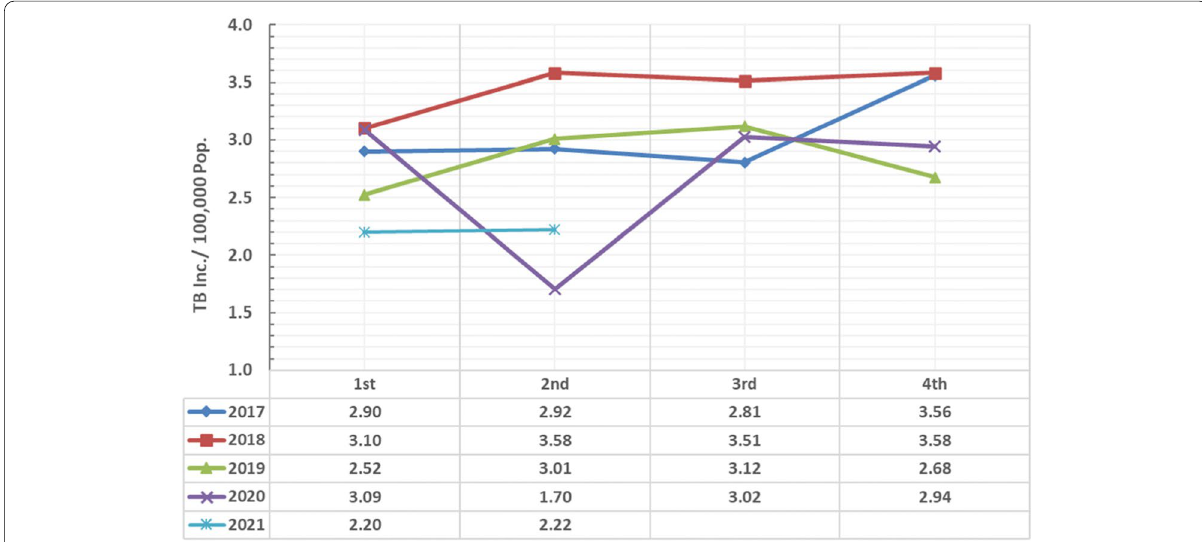
Fig. 3 TB incidence trends in different years (2017–2021) with comparison between quarters in Assiut Chest Hospital, Egypt